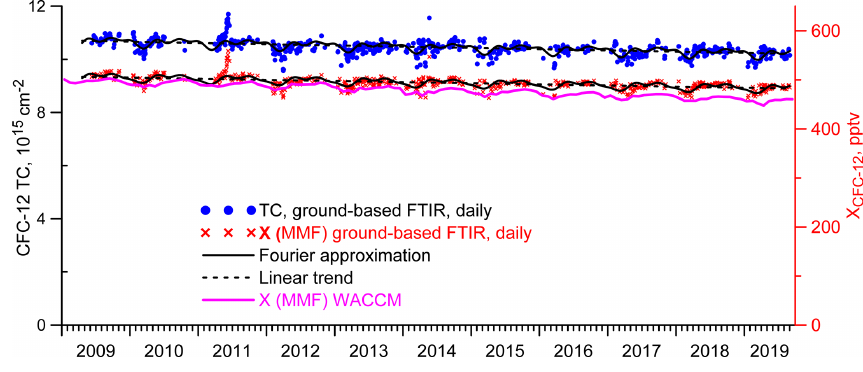
Figure 5. Daily mean TCs and Xgas of CFC-12. Filtered results of the T − Ph parameter α = 85.